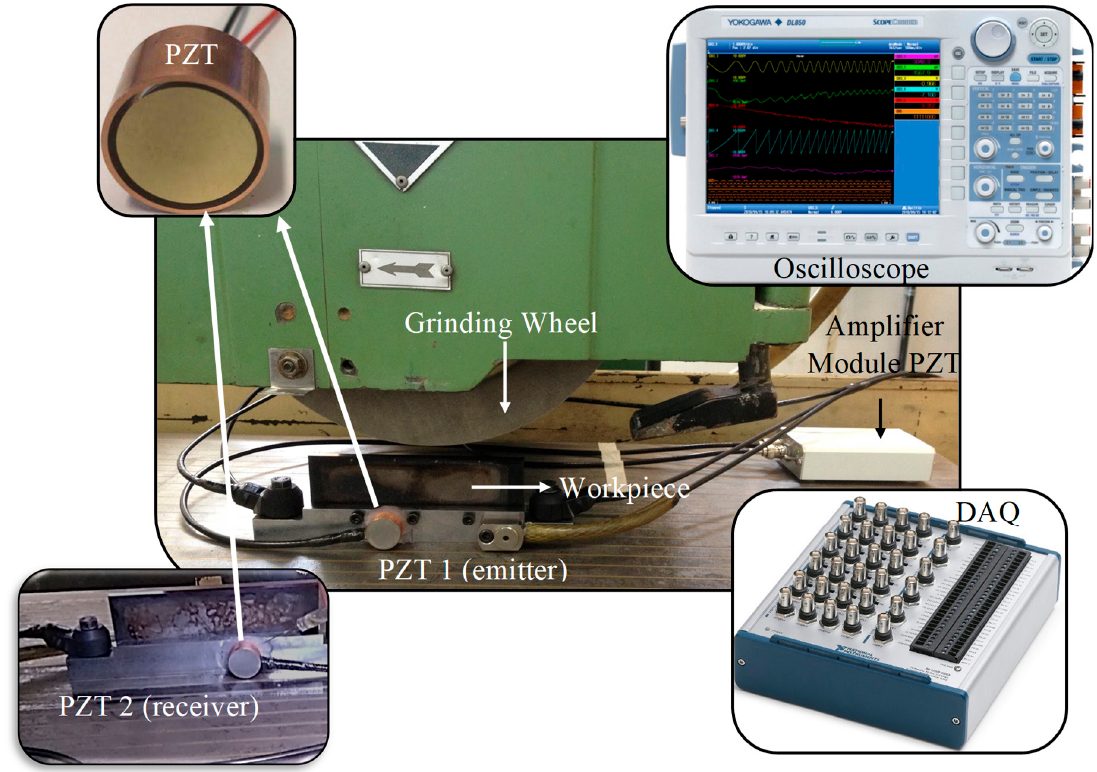
Figure 3. Experimental Setup.